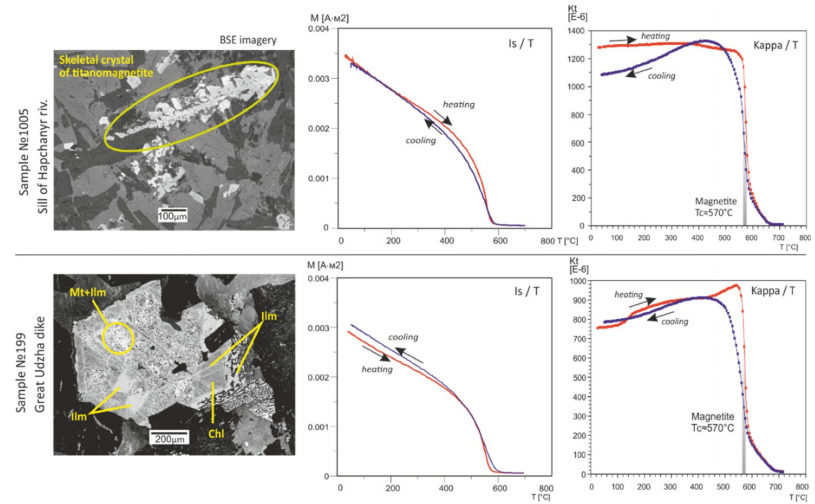
Figure 6. Data of microprobe analysis (BSE imagery), the relation of the saturation magnetization from temperature and susceptibility versus the temperature for heating and cooling for rocks of the Great Udzha Dyke and the sill at the Udzha and Hapchanyr river junction. Abbreviation for SEM imagery: Mt—magnetite; Ilm—ilmenite;